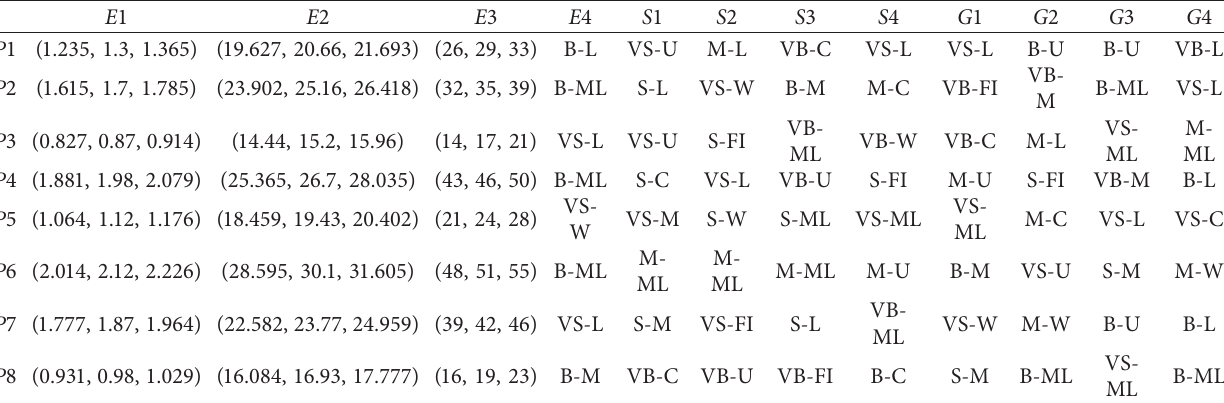
Table 22: Linguistic scoring variable matrix of sustainability criteria, considering the probability for proposed projects.